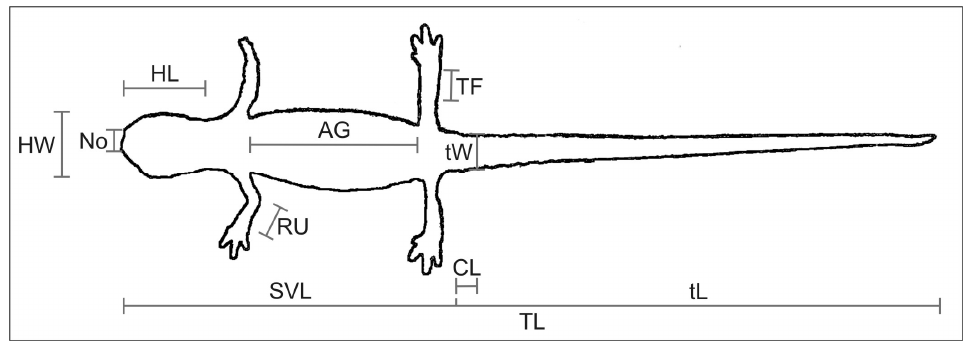
Figure 1. Biometric features of Salamandrina perspicillata and S. terdigitata used for the study: AG: distance between axilla and groin, CL: cloaca length, HL: head length, HW: head width, No: distance between nostrils, RU: radius-ulna (forearm) length, SVL: snout-vent length, TF: tibia-fibula (leg) length, TL: total length, tL: tail length, tW: tail